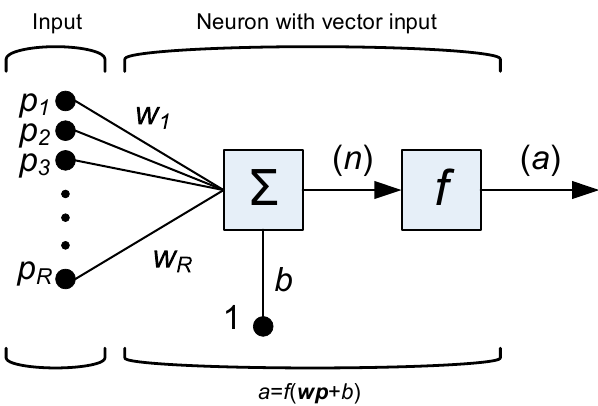
ffi cient (R)-element input